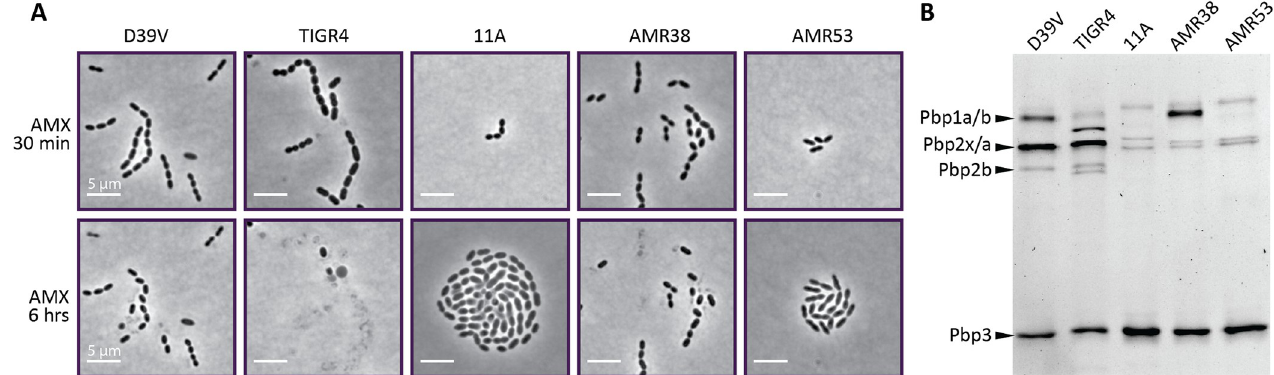
Fig 3. Phenotypic characterization of key strains used in this study. ( A ) Phase-contrast snapshots of recipient strains D39V and TIGR4, donor strain 11A, and recombinant strains AMR38 (generation 1) and AMR53 (generation 2) on C+Y agarose pads after 30 minutes and 6 hours of treatment with 1 μ g/mL AMX. This concentration was above MIC for D39V, TIGR4, and AMR38, and lead to a complete stall in growth and partial lysis. Donor strain 11A grew well in this AMX concentration, although some heterogeneity in cell shape could be observed. Although lower than the AMX MIC for AMR53, this strain showed decreased growth and abnormally elongated cells, indicating cells were stressed. Scale bar is 5 μ m. (B) Bocillin-FL binding patterns for the same five strains. Expected PBP band sizes for D39V are shown on the left. Image of Coomassie stained gel can be found in S1